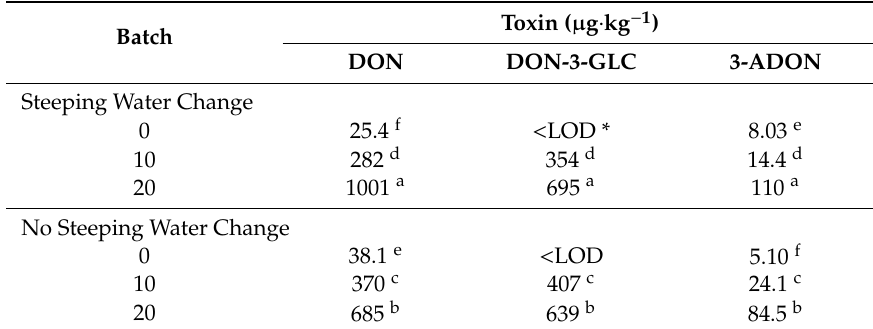
Table 3. Concentrations of DON (deoxynivalenol) and its derivates (deoxynivalenol-3-glucoside and 3-acetyldeoxynivalenol) in malt samples.